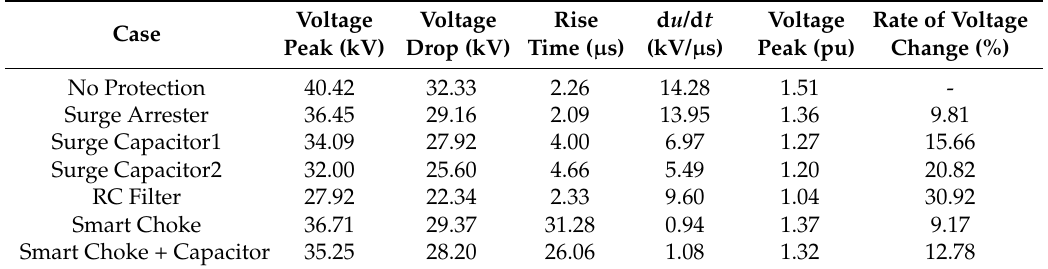
Table 3. Summary of the overvoltage from the typical worst